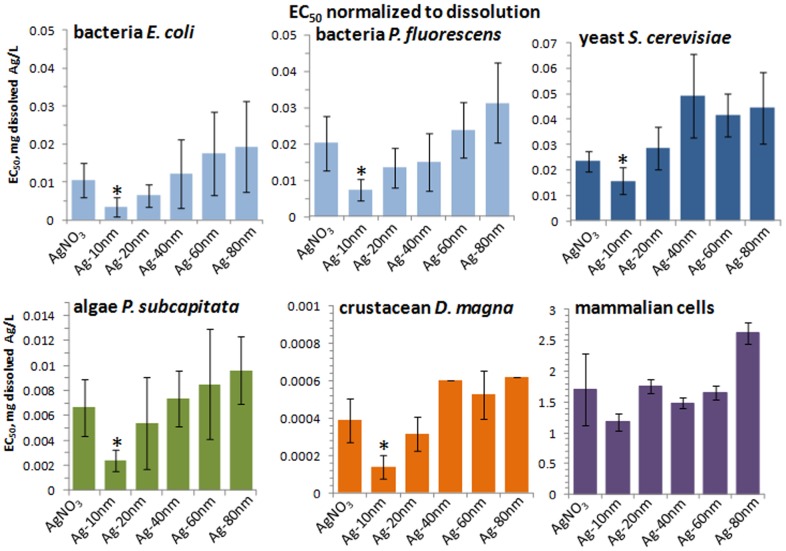
Dissolution-corrected EC50 values of 10–80 nm Ag NPs and AgNO3.EC50 values presented in Figure 4 (lower panel) were normalized for dissolved Ag (for dissolution, see Figure 3). * - significantly (p<0.05) different from EC50 of AgNO3.